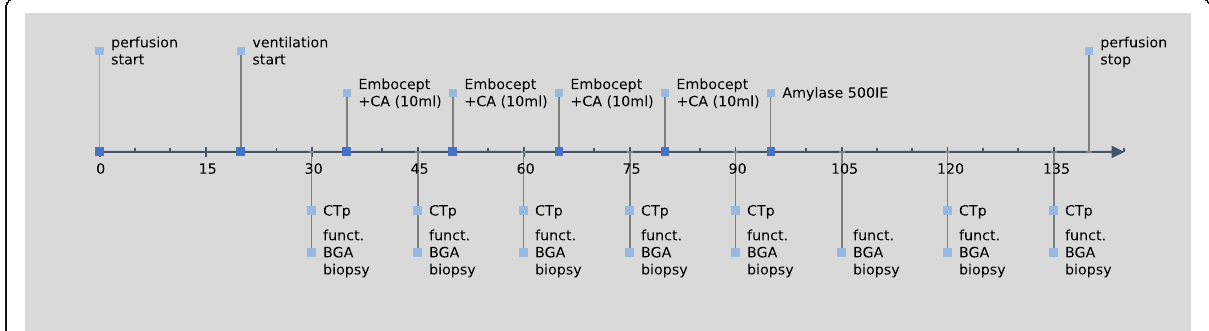
Fig. 4 Timeline of the experiment. BGA Blood gas analysis, CA Contrast agent, CTPI Computed tomography perfusion imaging, Funct. Functional assessment. x axis values given in min